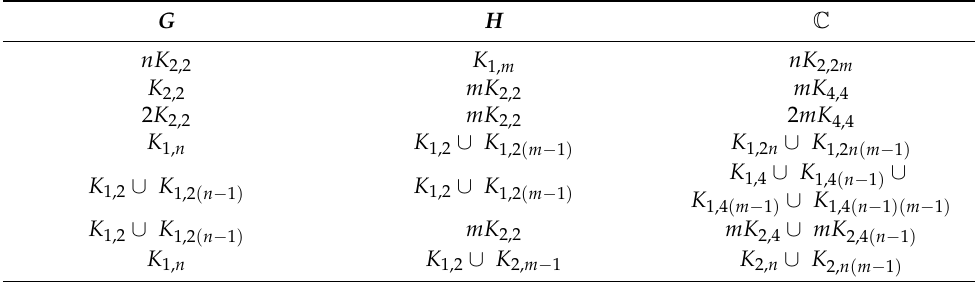
Table 1. Summary of results of Section 3.